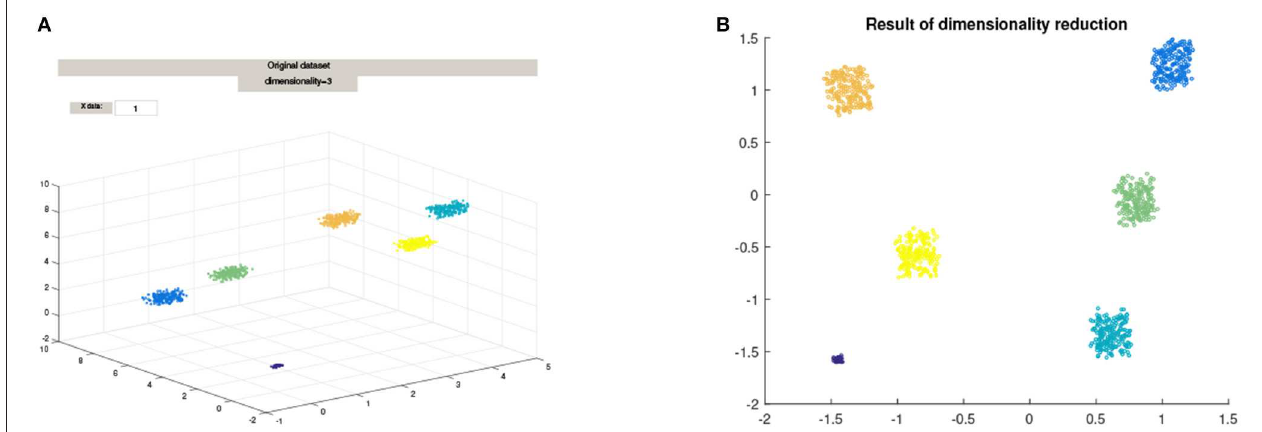
FIGURE 1 | The mapping of a 3D cluster using Diffusion Maps from the Matlab package drtoolbox https://lvdmaaten.github.io/drtoolbox/. (A) Original 3D Cluster, (B) Mapped data using Diffusion